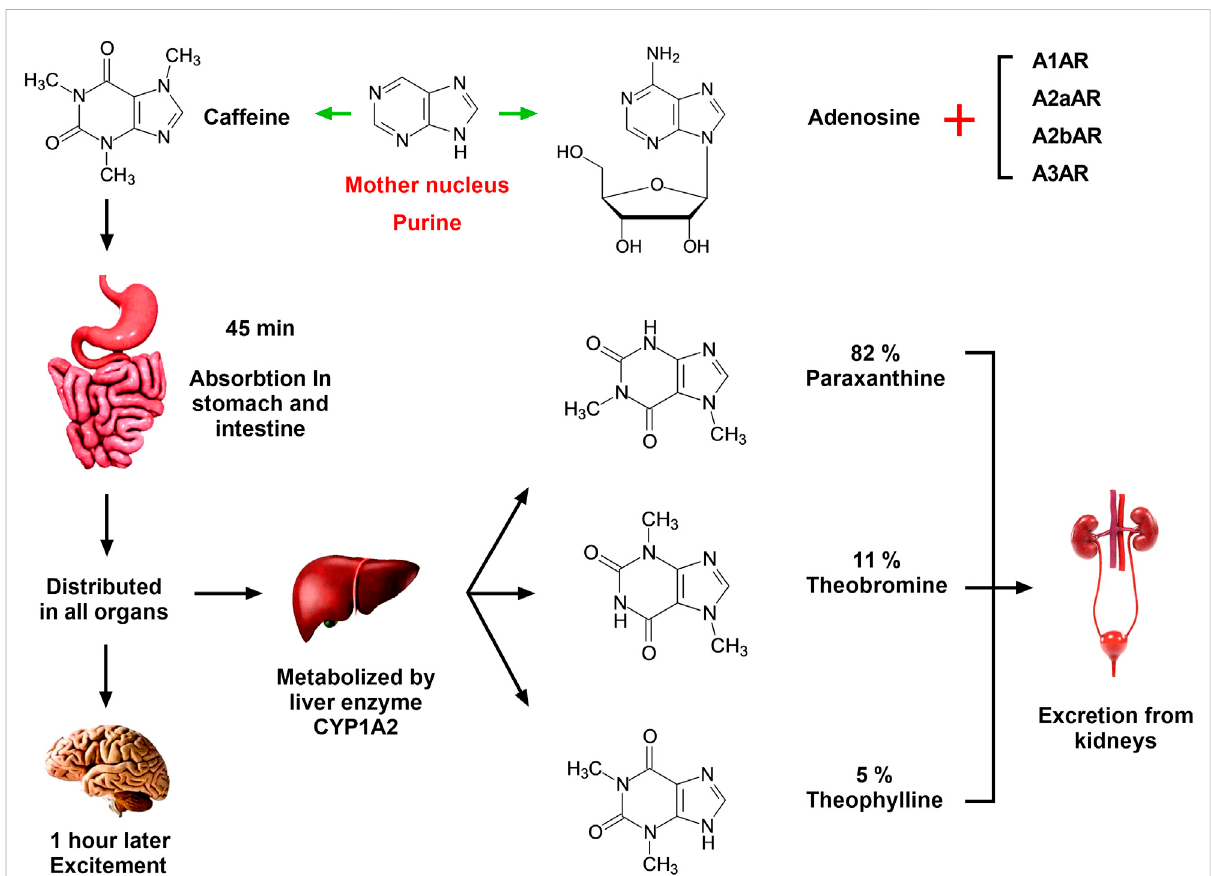
FIGURE 1 Absorption, distribution, metabolism, and excretion of caffeine in the human body. Caffeine has a similar chemical structure to adenosine, and the mother nucleus of both is purine. Therefore, caffeine is a natural non-selective antagonist of adenosine, which can competitively inhibit the binding of adenosine and ARs in vivo and play different physiological functions. Caffeine is completely absorbed by the stomach and small intestine within45 minoforaladministration,followingwhichitisdistributedinallorgansofthebodyandentersthecentralnervoussystemthroughthe bloodwithin1 h.Inthecentralnervoussystem,caffeinecancombinewithARsandcausecentralnervoussystemexcitement.Caffeineiscatalyzedby CYP1A2 in the liver to produce three primary metabolites: parxanthine (82%), theobromine (11%), and theophylline (5%). The conversion process is a fi rst-order chemical kinetic reaction, and these compounds are further metabolized and eventually excreted in the